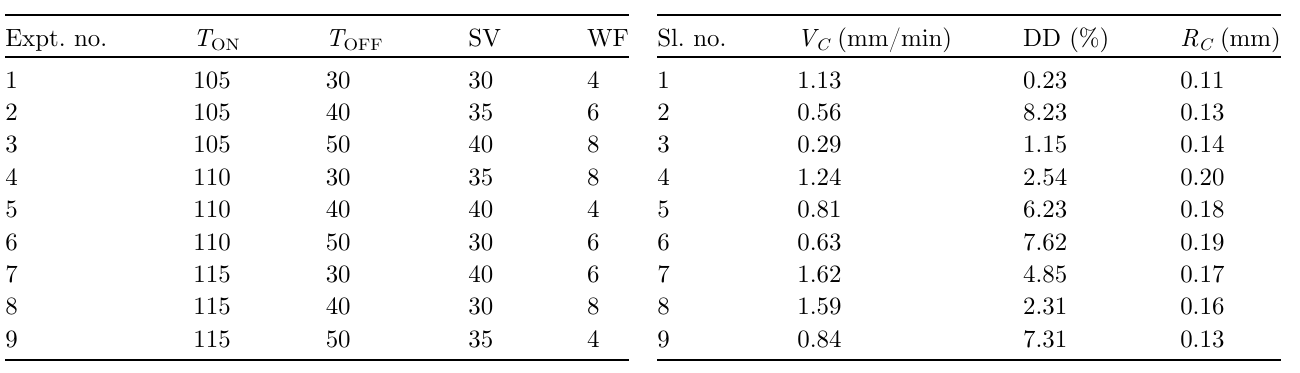
Table 3. Taguchi ’ s L